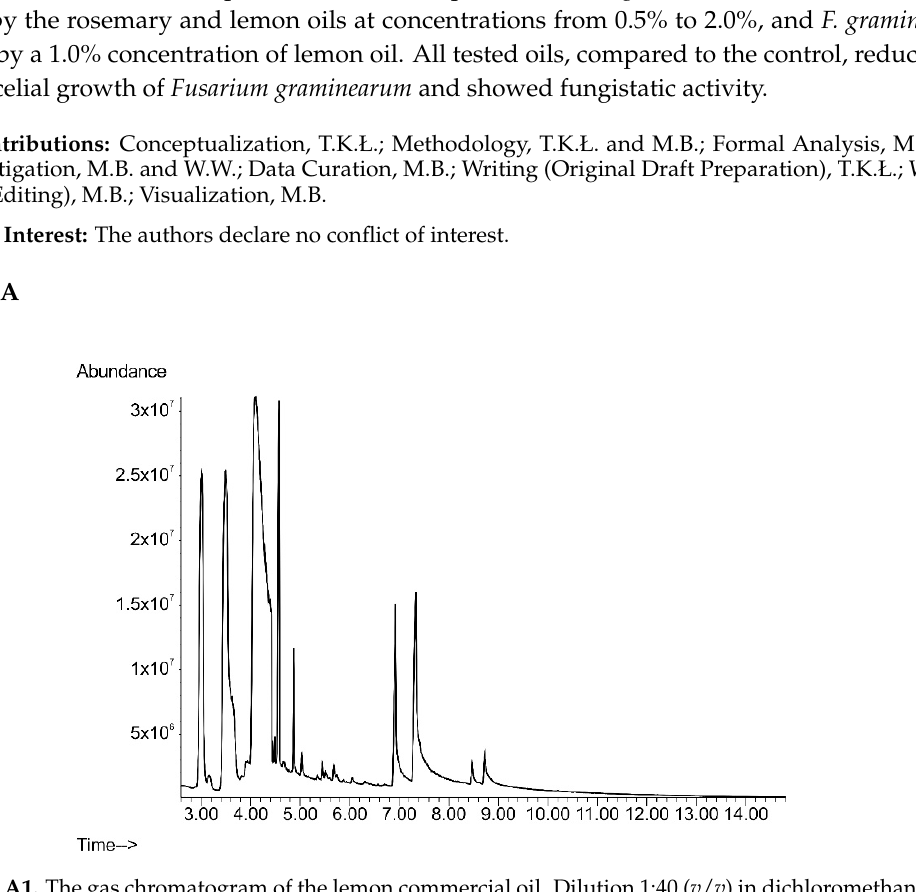
Figure A1. The gas chromatogram of the lemon commercial oil. Dilution 1:40 ( v / v ) in dichloromethane.